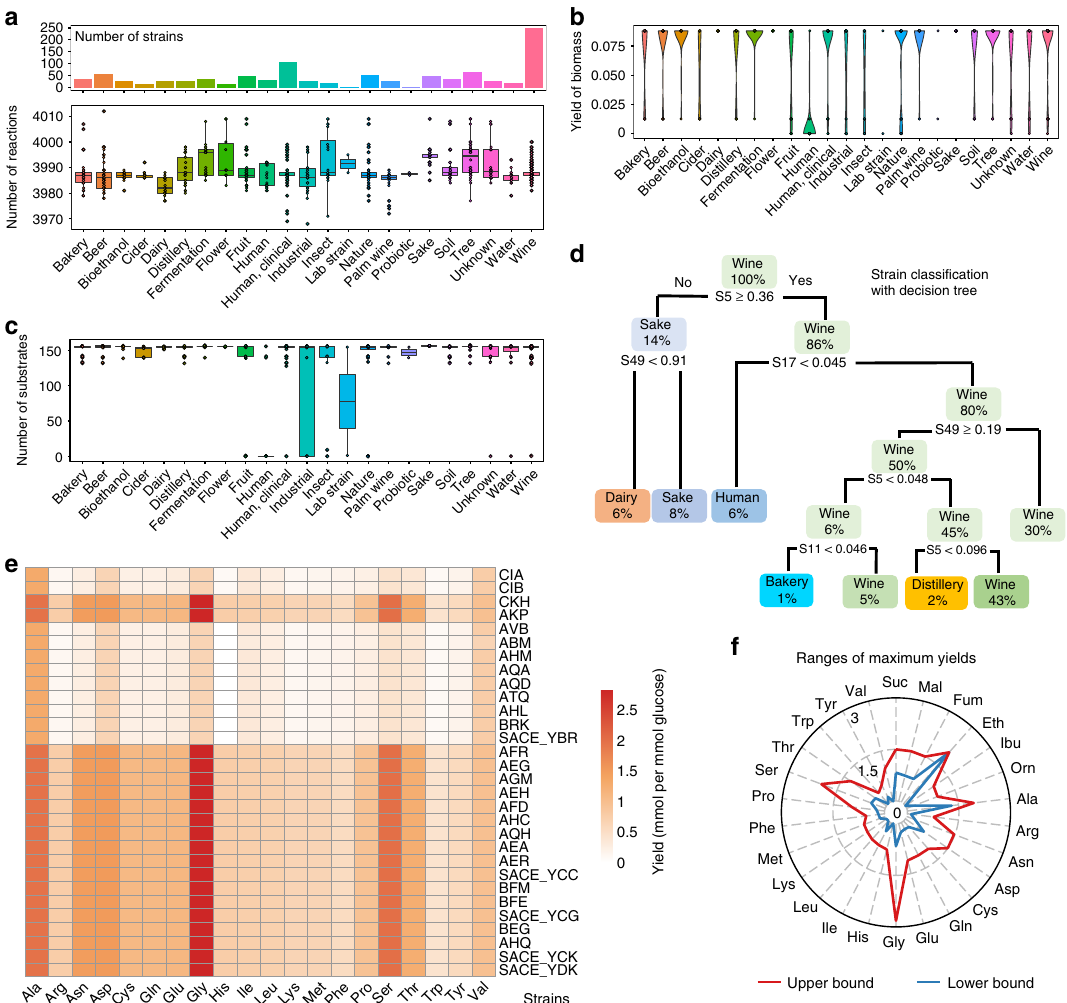
Fig. 3 Conservation and diversity analysis of yeast metabolism through reconstruction of 1,011 strain-speci fi c GEMs (ssGEM). a Amount of reactions of ssGEMs for strains from different ecological origins. The top column graph describes the strain number from each ecological origin. Different strains from one ecological origin could have the equal number of reactions. In the box plots of this work, if not mentioned, the bold line in the box represents the median. The lower and upper bounds of box show the fi rst and third quartiles, respectively, and whiskers indicate ± 1.5× the interquartile range (IQR). The color dots overlaid represent the corresponding data points. b Prediction of biomass yield using ssGEMs on minimal media with glucose as the carbon source. c Number of substrates which can be used in silico for strains from different ecological origins. In the simulation using ssGEMs, 58 carbon sources, 46 nitrogen sources, 41 phosphate sources and 12 sulphate sources were used respectively in the minimal media. d Decision tree classi fi cation of strains according to the in silico maximum growth rate on different carbon sources (S5: Latic acid, S11: Serine, S17: Sorbitol, S49: Trehalose). The in silico uptake rate for each carbon source was set at 10 mmol (gBiomass) − 1 h − 1 . e Comparison of the yield of 20 amino acids from glucose for 30 strains from the group of “ industrial strain ” . f Comparison of in silico range of maximum yields of 20 amino acids and six key chemicals for all 1011